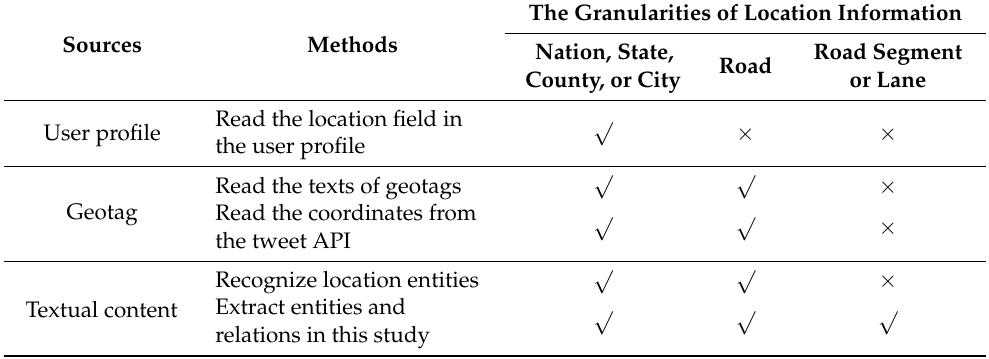
Table 2. The granularities of location information in existing SMDbSs.